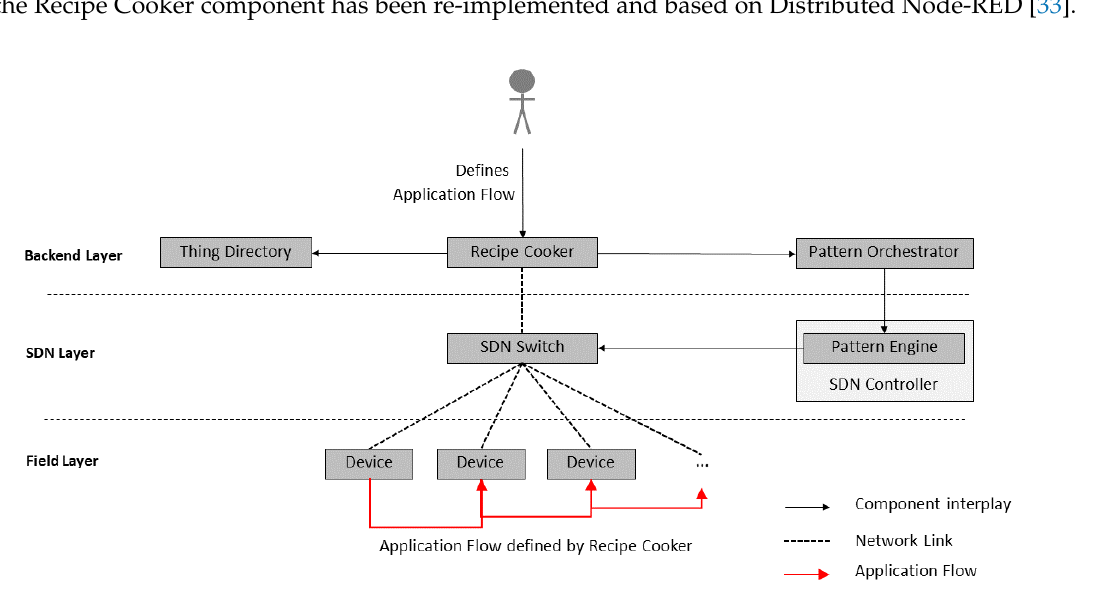
Figure 1. Overview of architectural components and their